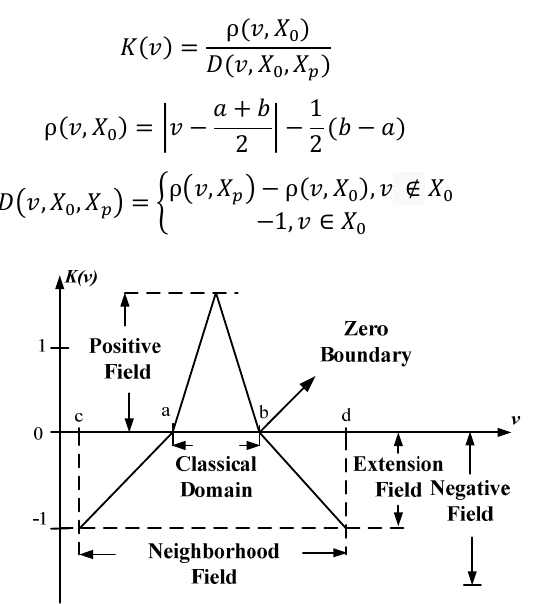
Figure 5. Extenics set correlation function schematic.